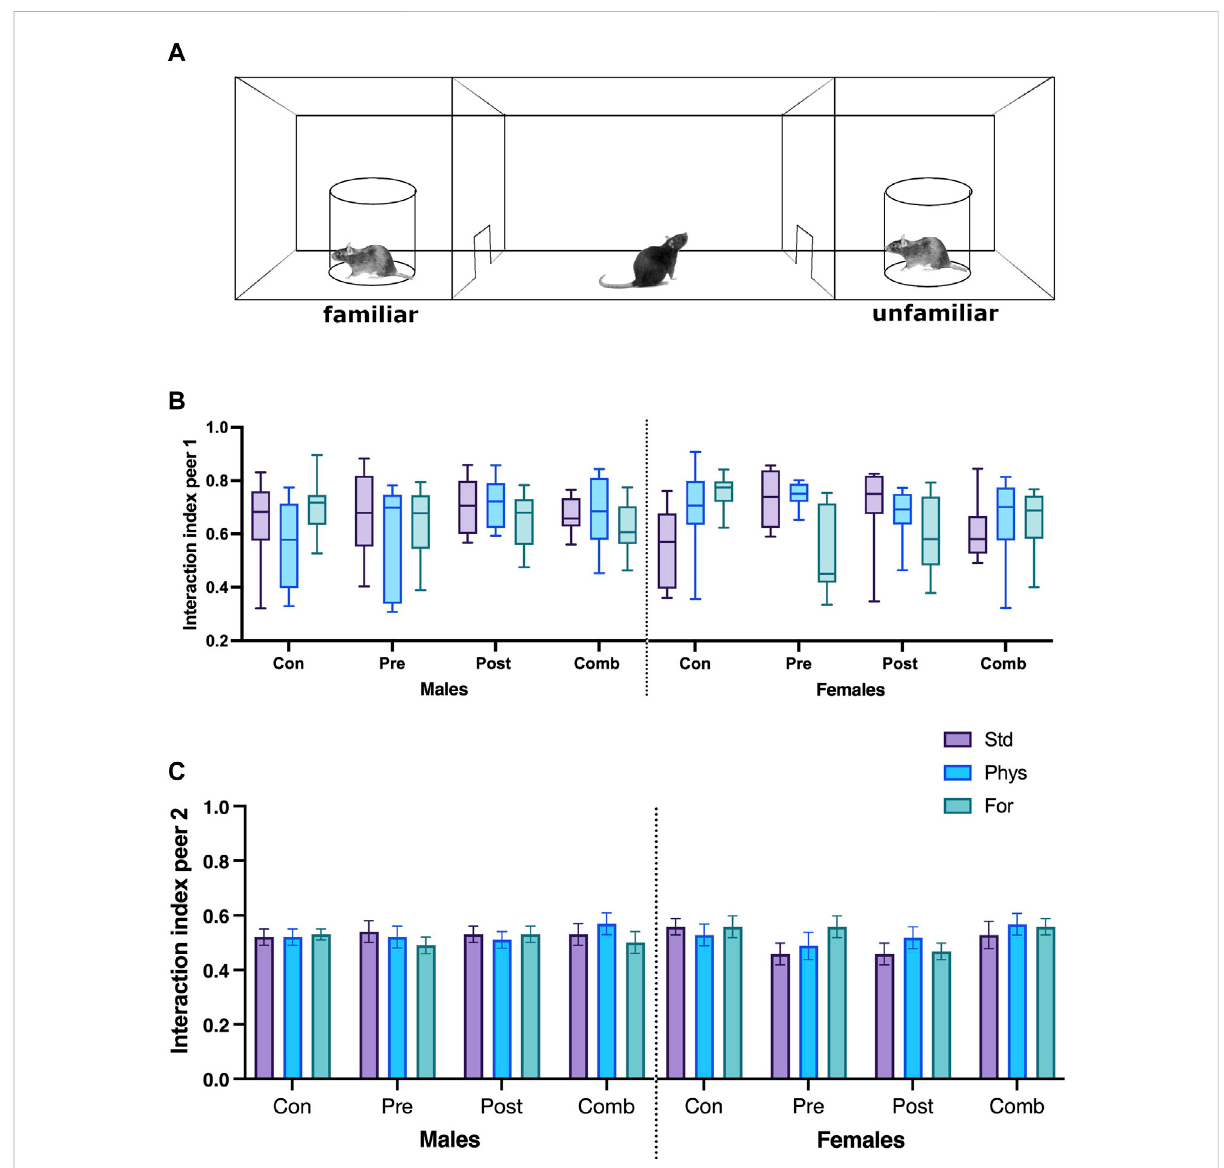
FIGURE 6 Social interaction test schematic diagram (A) . Interaction index with peer 1 (B) and peer 2 (C) . Abbreviations: ELS, Early life stress; Con, Control; Pre,Prenatal;Post,Postnatal;Comb,Combined;EE:Std,Standard;Phys,Physical-EE;For,Foraging-EE;Comb,Combined.Nosigni fi cantdifferences were found between the groups (Kruskal –